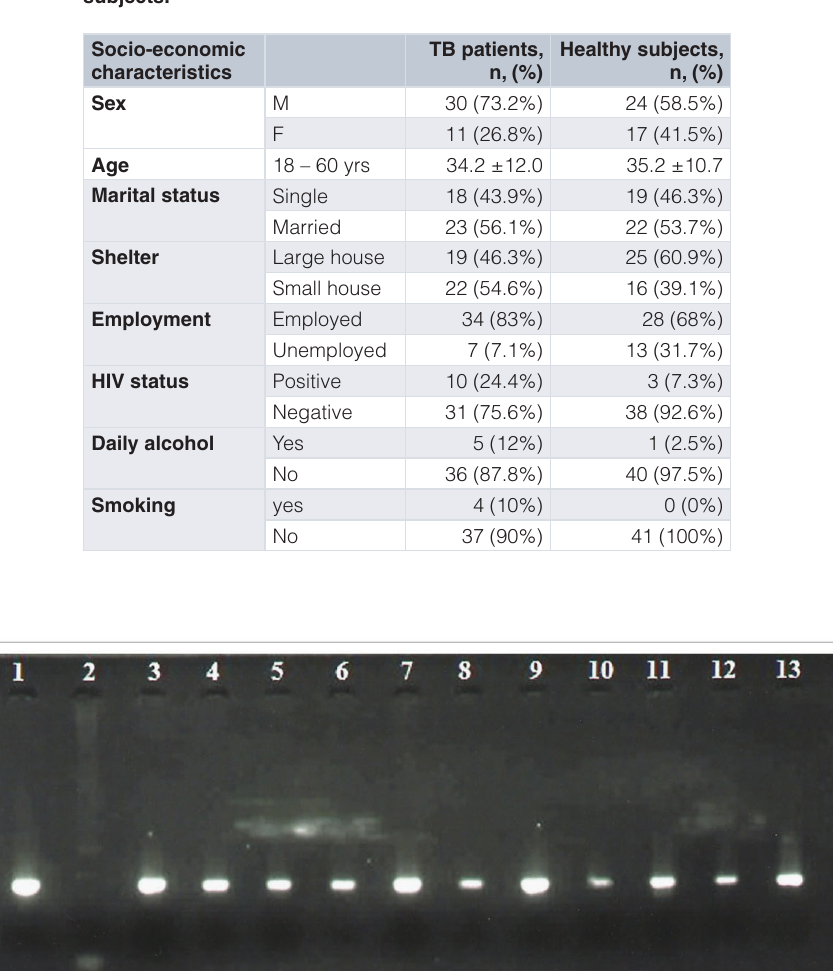
Table 1. The social economic and demographic characteristics of 82 subjects.